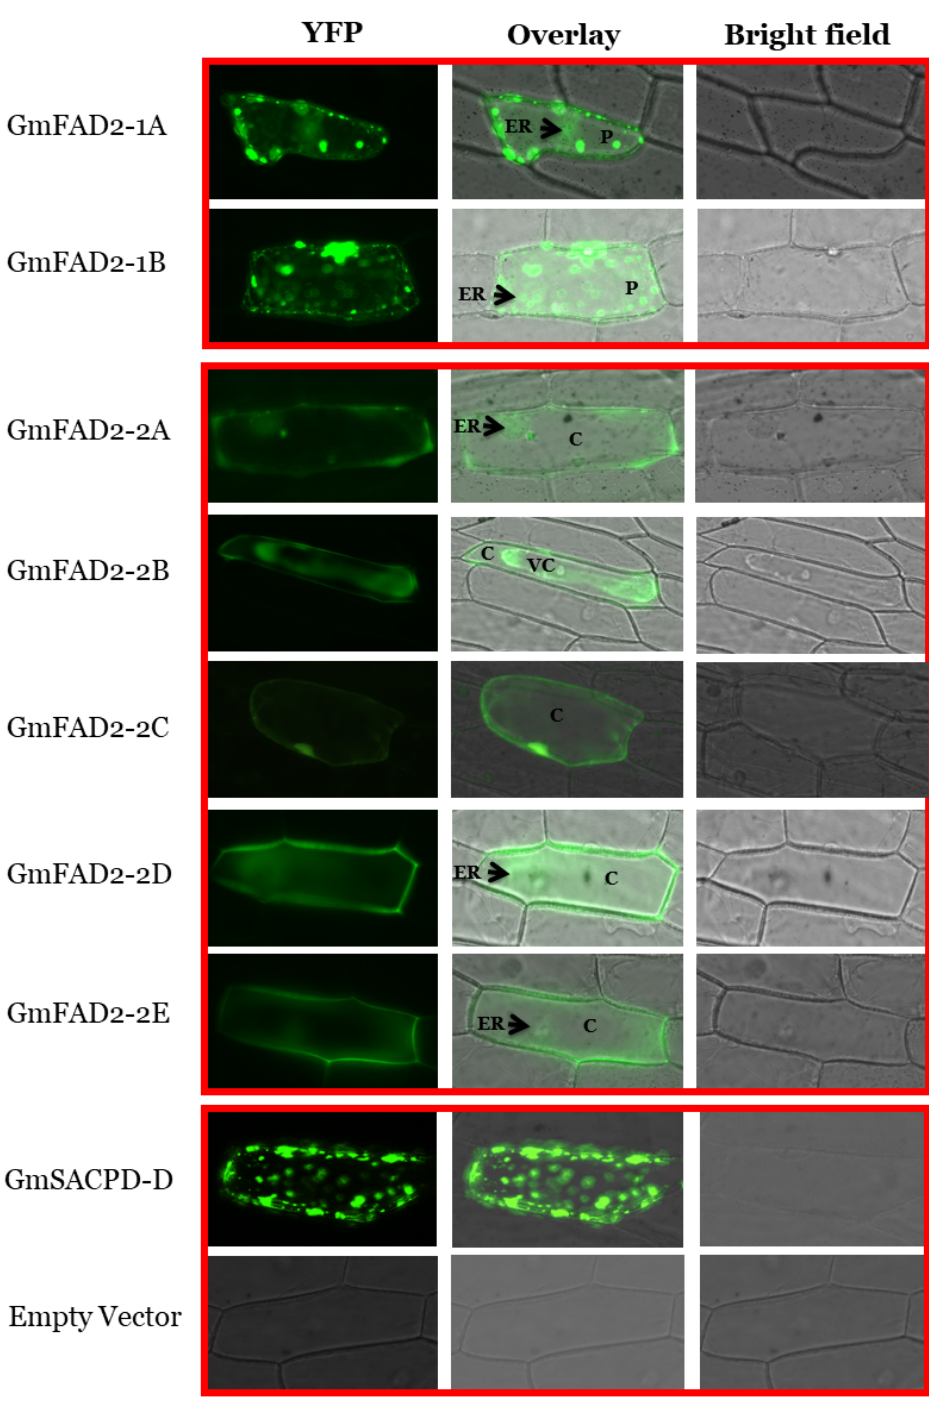
Figure 4. Subcellular localization of soybean GmFAD2-1 and GmFAD2-2 proteins. The GmFAD2 coding sequences from all seven members were fused to eYFP and delivered into onion epidermal cells using biolistic bombardment. GmFAD2-1A and GmFAD2-1B showed an endoplasmic reticulum (ER) and chloroplastic (P) localization pattern. GmFAD2-2A, GmFAD2-2D, and GmFAD2-2E showed a reticulum endoplasmic and cytosol (C) localization. GmFAD2-2C signal was found in the cytosol only. GmFAD2-2B shows a vacuole (VC) and cytoplasmic localization. The chloroplast-targeted GmSACPD-D was used as positive control [29]. Bar = 100 µM.